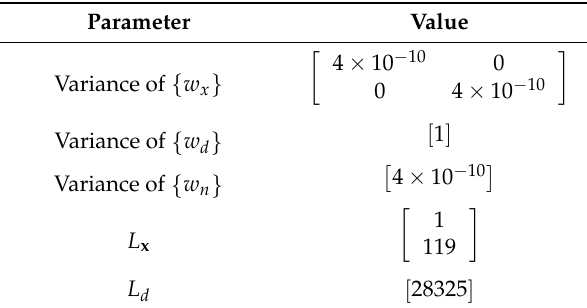
Table 2. Kalman filter design parameters.